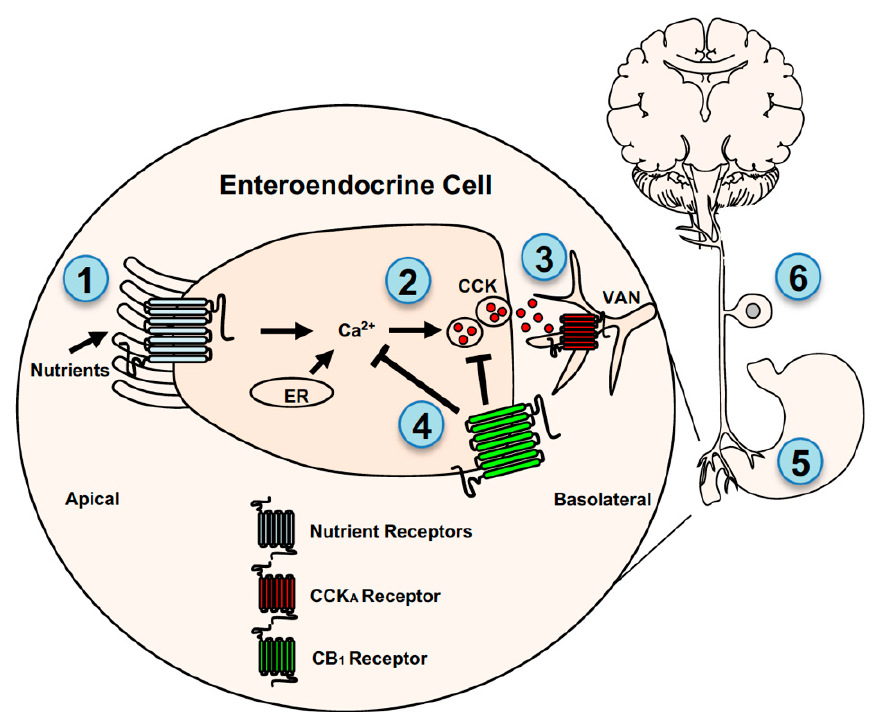
Figure 2. Endocannabinoid system control of gut-brain signaling. CB 1 Rs are located on enteroen- docrine cells in the small-intestinal epithelium, stomach cells, and vagal afferent neurons (VANs) where they indirectly and directly control gut-brain neurotransmission. CB 1 Rs are thought to indi- rectly interact with VANs by a mechanism that includes controlling nutrient-induced secretion of the satiation peptide, cholecystokinin (CCK), from enteroendocrine cells. Nutrients, including fatty acids and glucose/sweeteners, are sensed by mechanisms that may include several distinct G-protein coupled receptors (GPRCs) located on the apical and/or basolateral membrane of enteroendocrine cells ( 1 ), which triggers calcium-dependent secretion of CCK ( 2 ) and other signaling molecules. Glucose sensing is also mediated by a mechanism that requires sodium-glucose linked transporter 1 located on the apical membrane of enteroendocrine cells. CCK activates adjacent CCK A receptors on VAN fibers ( 3 ). Levels of eCBs are elevated in the small-intestinal epithelium in rodent models of diet-induced obesity (see [25]), and their increased activity at local CB 1 Rs blocks nutrient-induced secretion of CCK ( 4 ) by a mechanism that is unclear but may include inhibition of Ca 2+ -mediated vesicular release of CCK (see [41]). Pharmacological inhibition of peripheral CB 1 Rs in diet-induced obese mice blocked overeating and restored the ability for nutrients to induce CCK release. Studies also suggest that CB 1 Rs on stomach cells (see [81]) may also indirectly interact with VANs by control- ling the formation of ghrelin, which can activate ghrelin receptors on VANs (5). Together these studies highlight an indirect mechanism for CB1R-mediated control of gut-brain signaling. CB1Rs may also directly control activity of VANs (6). CB1Rs are expressed in VANs and their expression is affected by feeding status, pharmacological administration of CCK and ghrelin, and diet-induced obesity (see [82–87]). Moreover, recent studies suggest that CB1Rs control mechanosensitivity of VANs, which may be dysregulated in diet-induced obesity (see [86,88,89]). ER = endoplasmic